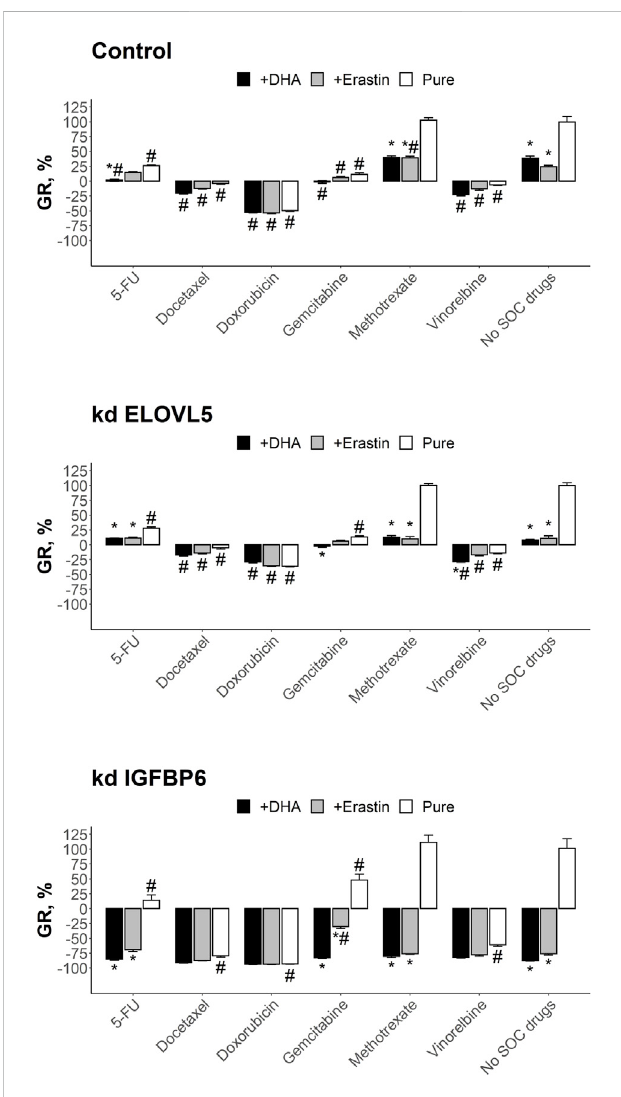
Results of the drug test for the tested SOC drugs and their combination with DHA and Erastin on the spheroids in Matrigel from MDA-MB-231 cells. Error bars represent standard error of mean (SEM, n = 3). * — p < 0.05 versus corresponding pure SOC treatment (without DHA or Erastin). # — p < 0.05 versus corresponding condition without SOC drugs (no SOC